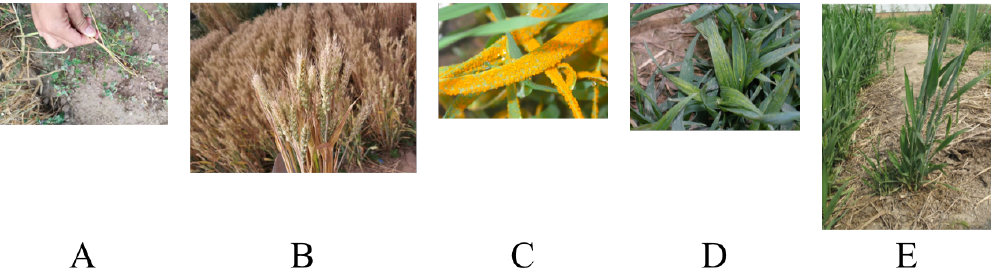
Figure 6. Examples of our dataset. ( A ) is the Macrophthalmia, ( B ) is the healthy, ( C ) is the rust, ( D , E ) are